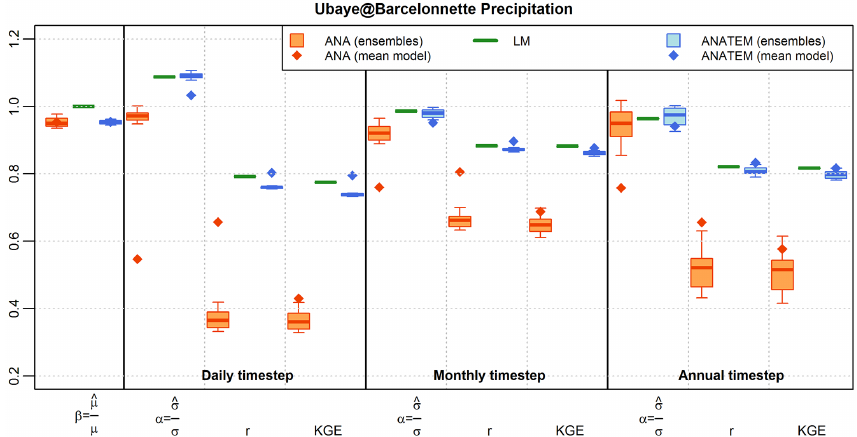
Figure 9. Daily, monthly and annual performance criteria of precipitation reconstructions for the Ubaye River at Barcelonnette watershed by the analogue (ANA), local (LM) and ANATEM models.